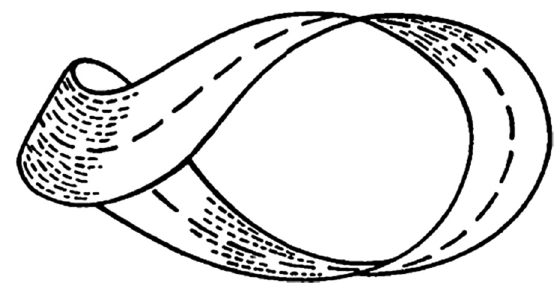
Figure 1: Möbius strip, from Jacques Lacan, “ Of Structure as an Inmixing of an Otherness Prerequisite to Any Subject Whatever, ” 192.